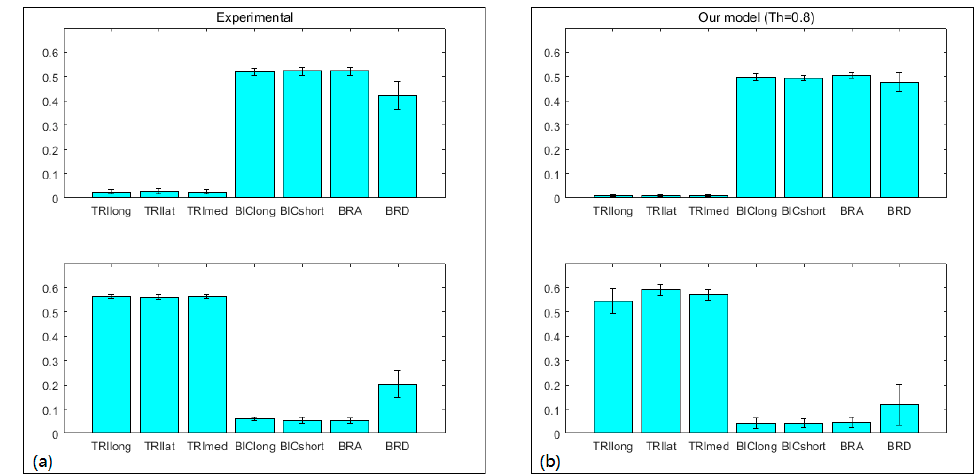
Figure 10. Muscle synergy analysis. NMF was used to extract muscle synergy patterns. ( a ) The experimental muscle synergy patterns; ( b ) the adjusted muscle synergy patterns ( (cid:1846)ℎ = 0.8). The scalar products between experimental and adjusted muscle synergy patterns are above 95% of all the four subjects.